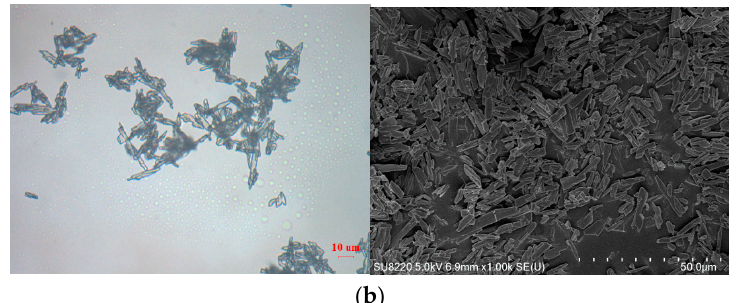
Figure 4. Images obtained by microscope and SEM of ( a ) Solid I and ( b ) Solid II.